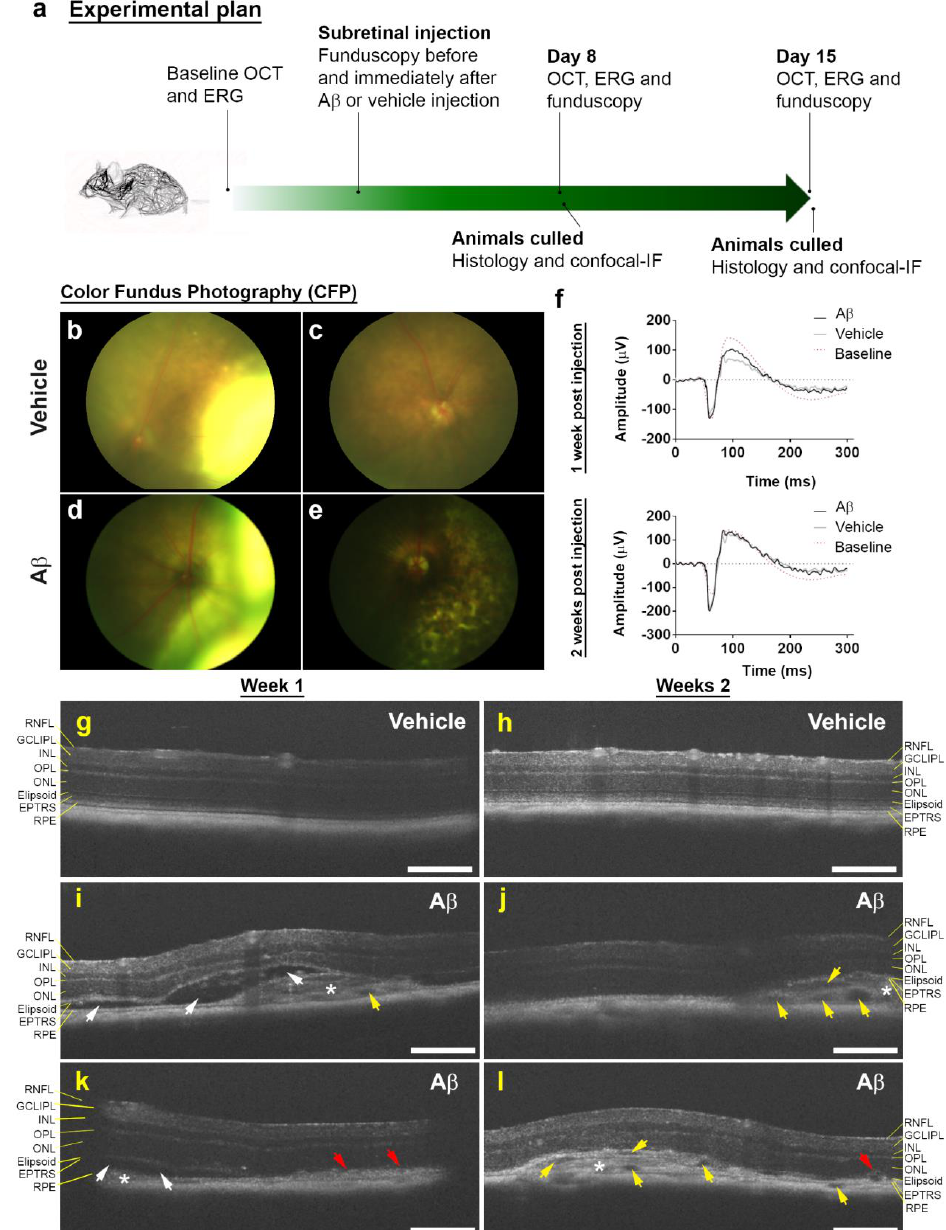
Figure 1. Subretinal A β effects in retinas of living mouse eyes. ( a ) Schematic plan showing experimental sequence. ( b ) Representative color fundus photograph (CFP) of mouse eye injected with vehicle immediately after and ( c ) 8 days following subretinal injection. Note, the appearance of a retinal bleb following a successful transscleral subretinal injection, which subsequently resolves. ( d ) Representative CFP of mouse eye injected with human oligomeric Aβ 1-42 immediately after and ( e ) 8 days later. Note superficial evidence of retinal pathology following exposure to Aβ. ( f ) Average scotopic ERG responses in mice injected with vehicle ( n = 6) or human oligomeric Aβ 1-42 ( n = 7) after 1 and 2 weeks. No significant differences in retinal function were observed between eyes injected with Aβ vs. controls by Mann–Whitney U test (two tailed). ( g ) Representative optical coherence tomography (OCT) images of vehicle and ( i , k ) human oligomeric A β 1-42 -injected eyes after 1 week. We observed areas of localized pathology in eyes exposed A β 1-42 consisting of RPE disruption (red arrows), subretinal fluid accumulation (white arrows) and hyper-reflective material (asterisk). There was also evidence of occasional hypo-reflective spaces (yellow arrows). However, by week 2, subretinal fluid accumulation appeared to have been largely resolved ( j , l ), but there was increasing evidence of hypo-reflective spaces. We also observed disrupted RPE and subretinal hyper-reflective material persisting in week 2. There was no evidence of pathogenic features in eyes injected with vehicle at either 1 or 2 weeks ( g , h ). Scale bars correspond to 200 µ